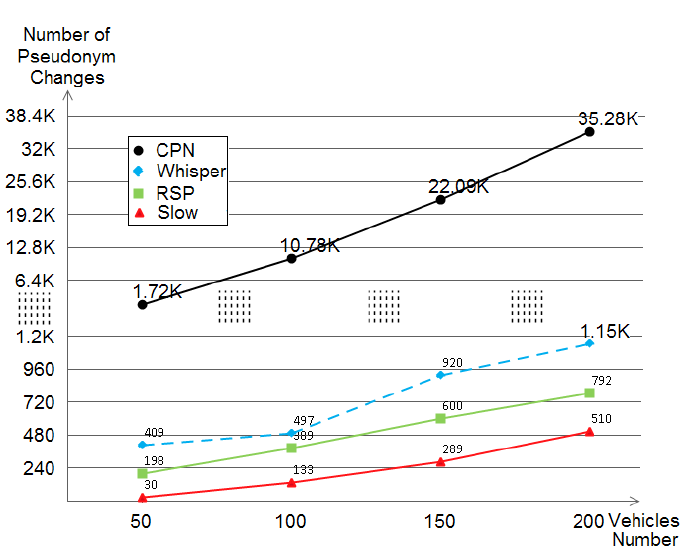
Figure 13. The pseudonyms changes (consumption) evaluation of CPN, WHISPER, RSP, and SLOW within different